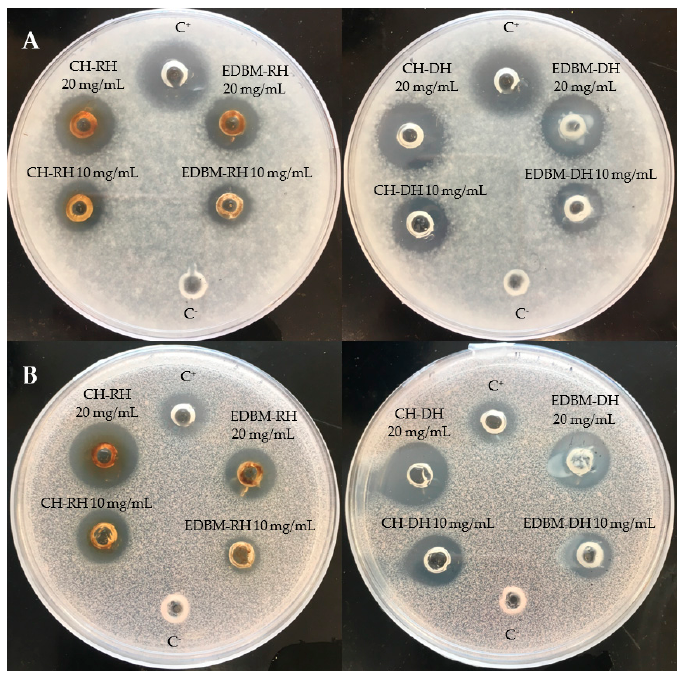
Figure 4. Inhibition zones induced by 2 different concentrations (10 and 20 mg/mL) of raw and discolored bovine hemoglobin hydrolysates produced by two different hydrolysis processes on potato dextrose agar (PDA) overlaid with a suspension (10 4 spores per plate) of Paecilomyces spp. ( A ) and Rhodotorula mucilaginosa ( B ) and compared to a positive (C + : natamycin) and negative control (C − : distilled